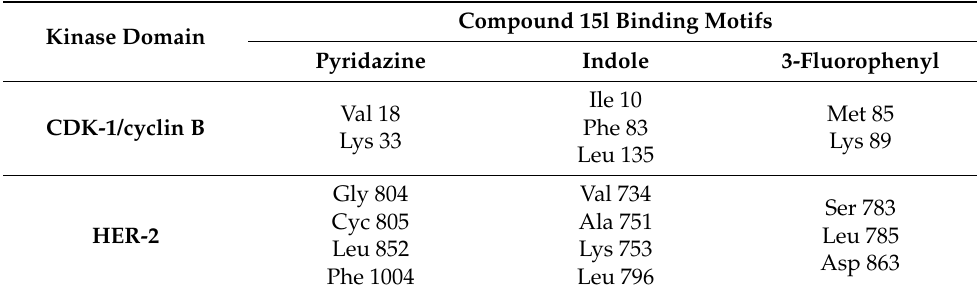
Table 5. Virtual binding interactions of compound 15l into CDK-1/cyclin B and HER-2 kinase domain binding